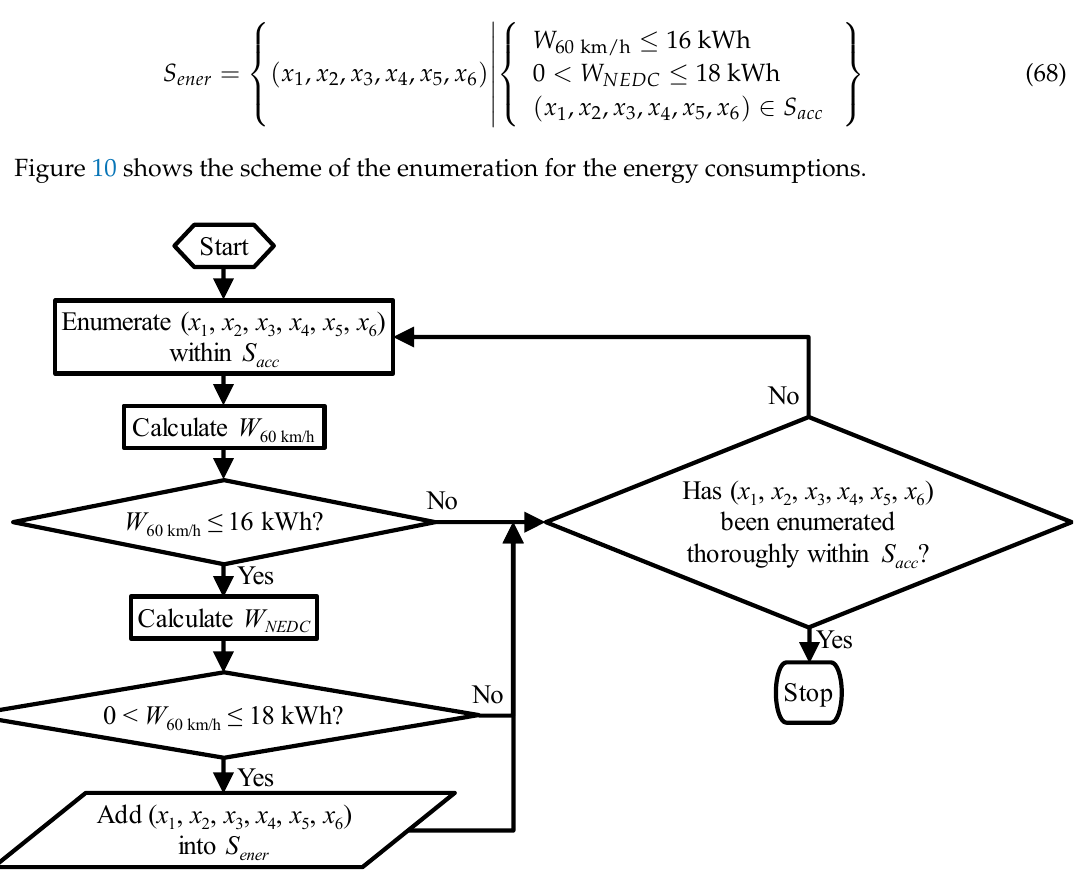
Figure 10. Scheme of the enumeration for the energy consumptions.